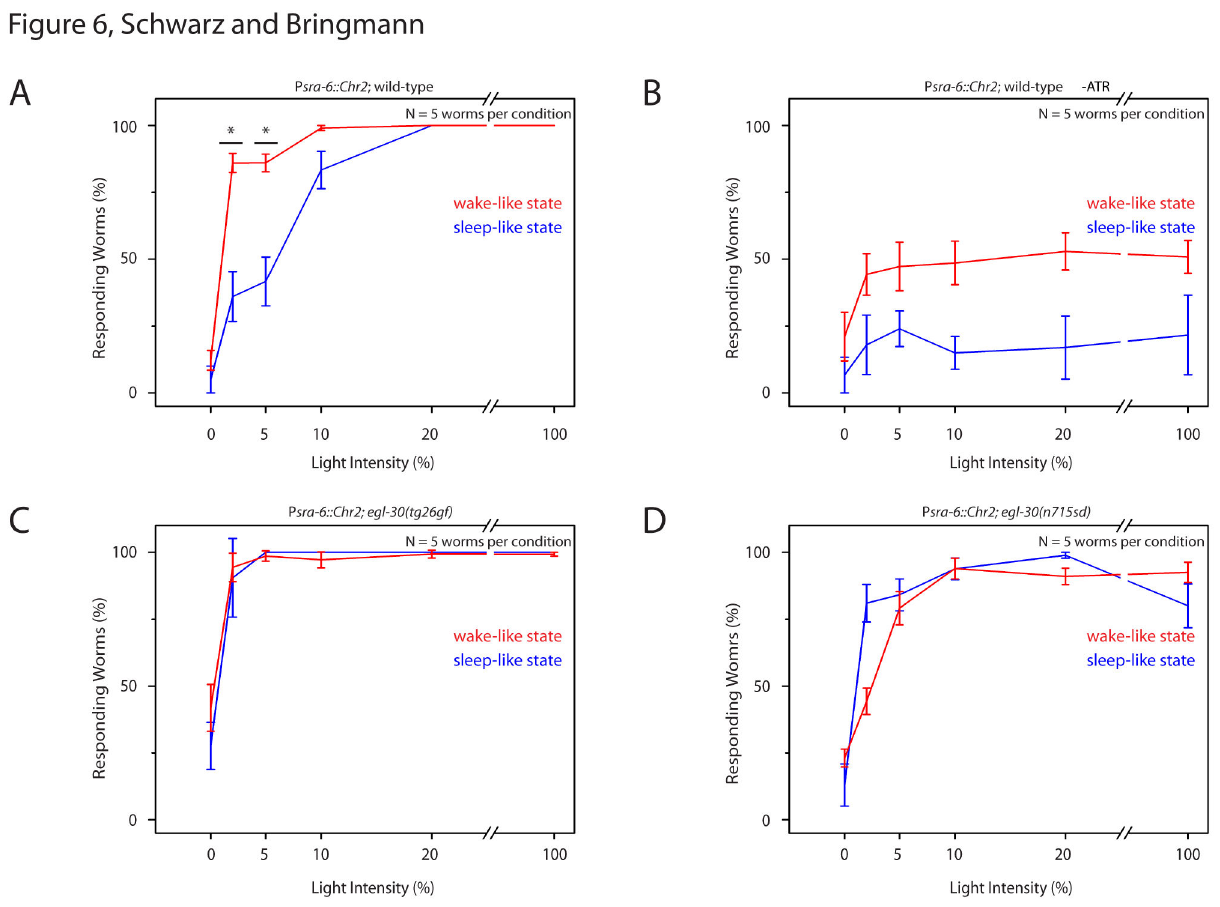
Figure 6. Reduced decrease of sensory responsiveness during sleep-like behavior in egl-30 mutants. A Light dose- dependent fraction of wild type worms reversing upon optogenetic ASH activation. Note that worms need higher LED intensity for half-maximal responsiveness during sleep-like behavior. B Wild type control without retinal. C Light dose-dependent fraction of worms reversing upon ASH activation during wake-like and sleep-like states in egl-30 (tg26gf). D Light dose-dependent fraction of worms reversing upon ASH activation during wake-like and sleep-like states in egl-30 (n715sd). Note that the intensity required for half-maximal responsiveness is not reduced during lethargus in egl-30 mutants. Error bars represent SEM. * represents p < 0.05, Wilcoxon Signed Ranks